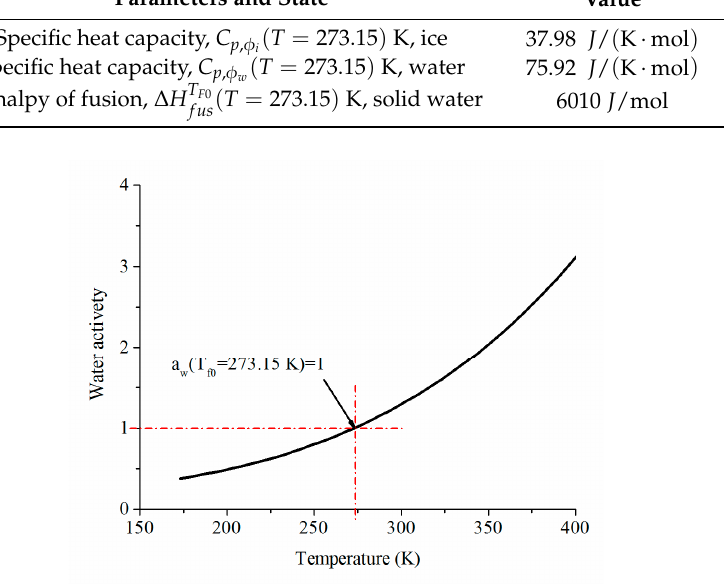
Figure 7. Relationship between water activity and temperature.